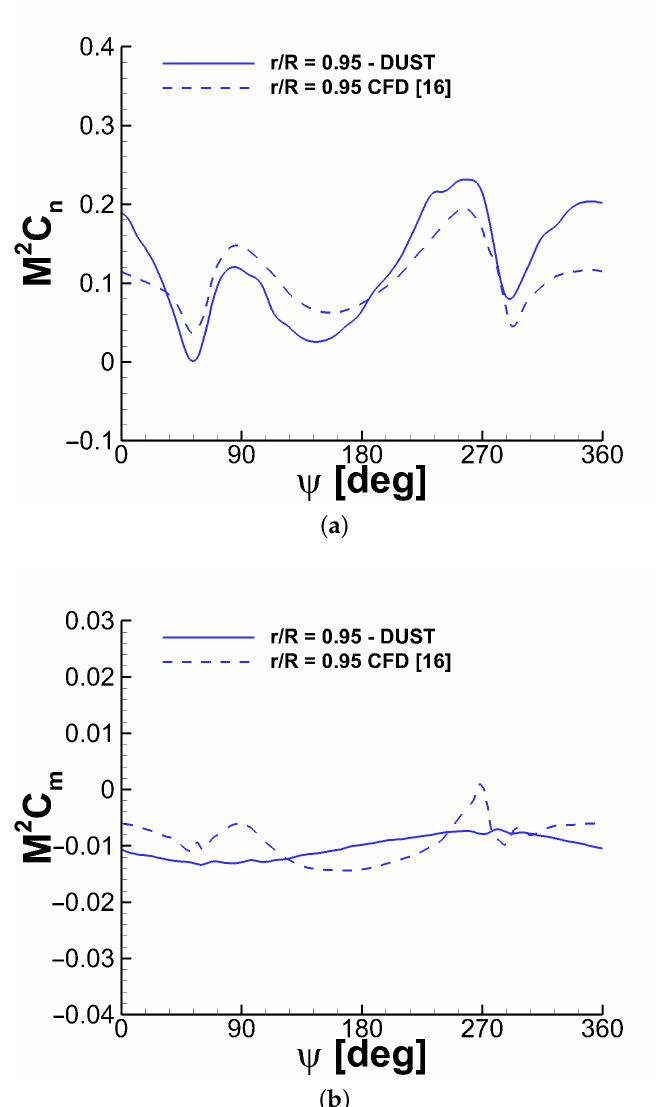
Figure 17. Comparison of the time histories of the non-dimensional normal force M 2 c n and pitching moment M 2 c m on the proprotor blade in conversion flight condition at r / R = 0.95, θ N = 75 ◦ , V ∞ = 40 kts, Ω = 589